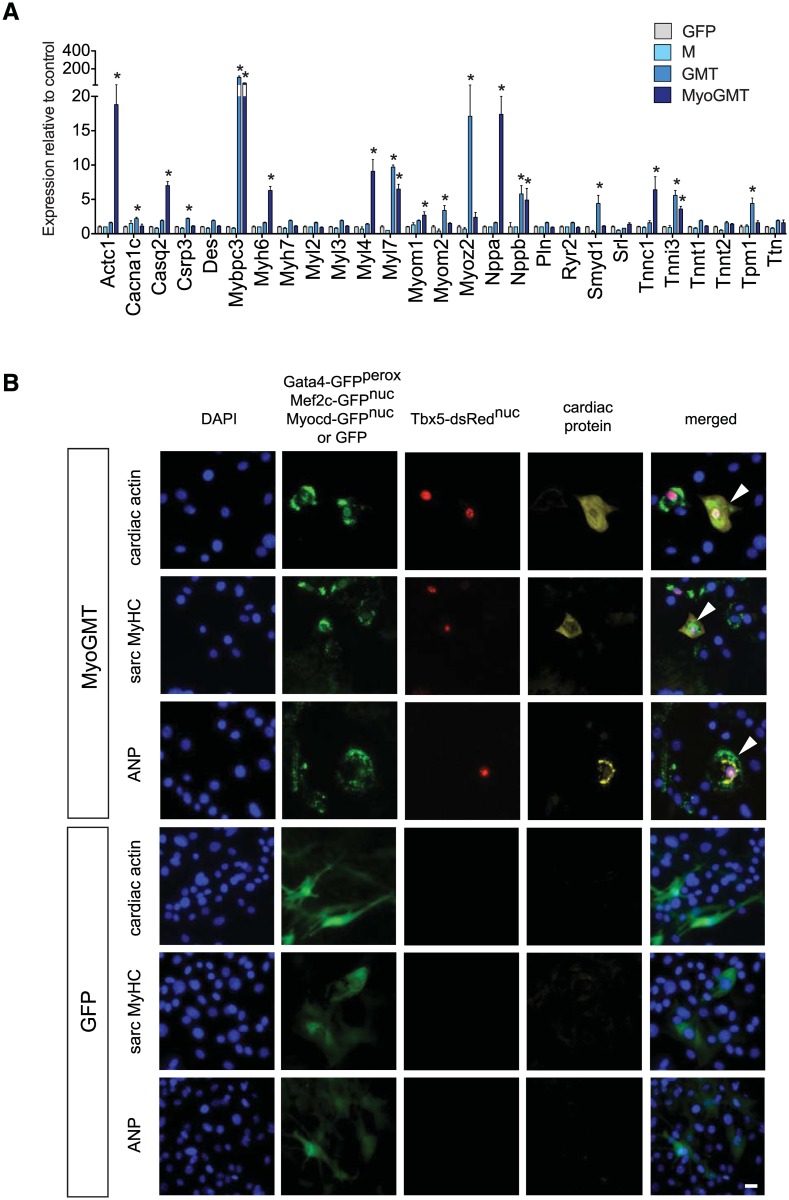
Cardiac gene and protein induction in CSCs by MyoGMT.A: QRT-PCR comparing MEF2C alone (the GMT factor absent from the CSCs), the GMT triad, and the 4-factor combination of MyoGMT. Data are the mean ± SD of three independent experiments. *, p <0.05, for factor-transduced versus GFP-transduced CSCs. Results here and in Fig 5 are taken from the identical three experiments, separated for clarity of the respective comparisons. B: Immunocytochemistry showing induction of the indicated cardiac proteins in CSCs by MyoGMT. Cells expressing the indicated proteins were identified using secondary antibodies conjugated with Alexa 647 (pseudocoloured yellow for enhanced visibility). Co-expression of GFPperox + GFPnuc + dsRednuc (expressed with the ectopic factors G, Myo / M and T, respectively), was assessed to identify the successfully co-transduced cells. No induction was detected in cells transduced with the GFP control vector (lower panels), or cells transduced with M and GMT in the absence of MYOCD (not shown). Similar results were observed in each of two independent experiments.